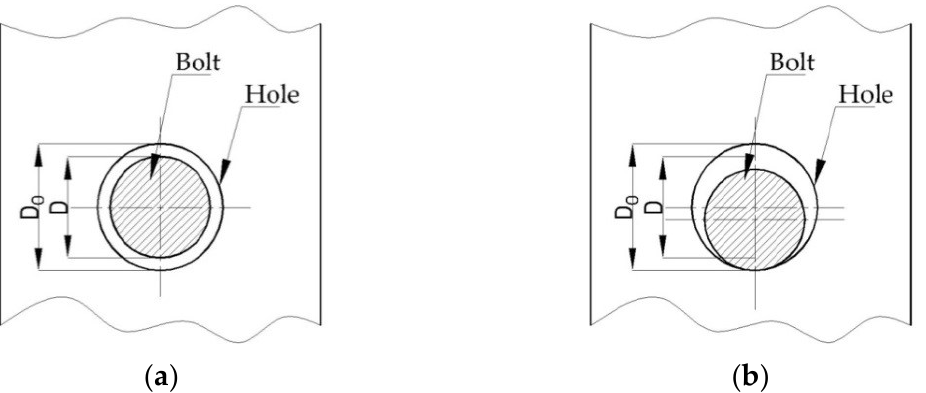
Figure 1. Clearance in bolted connections: ( a ) clearance between bolt and hole; ( b ) bolt in contact with the hole.